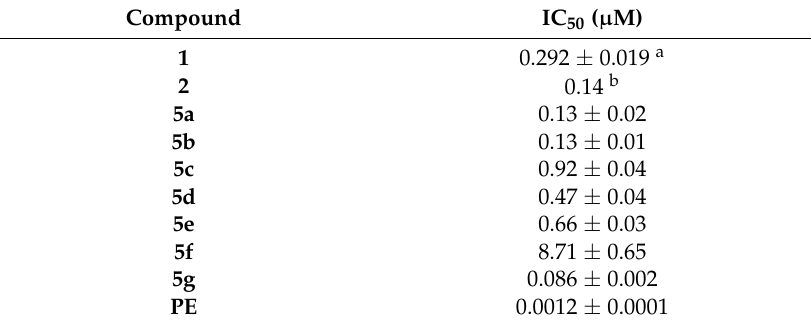
Table 2. In vitro antitrypanosomal activities of cinnamic acid-benzoxaborole